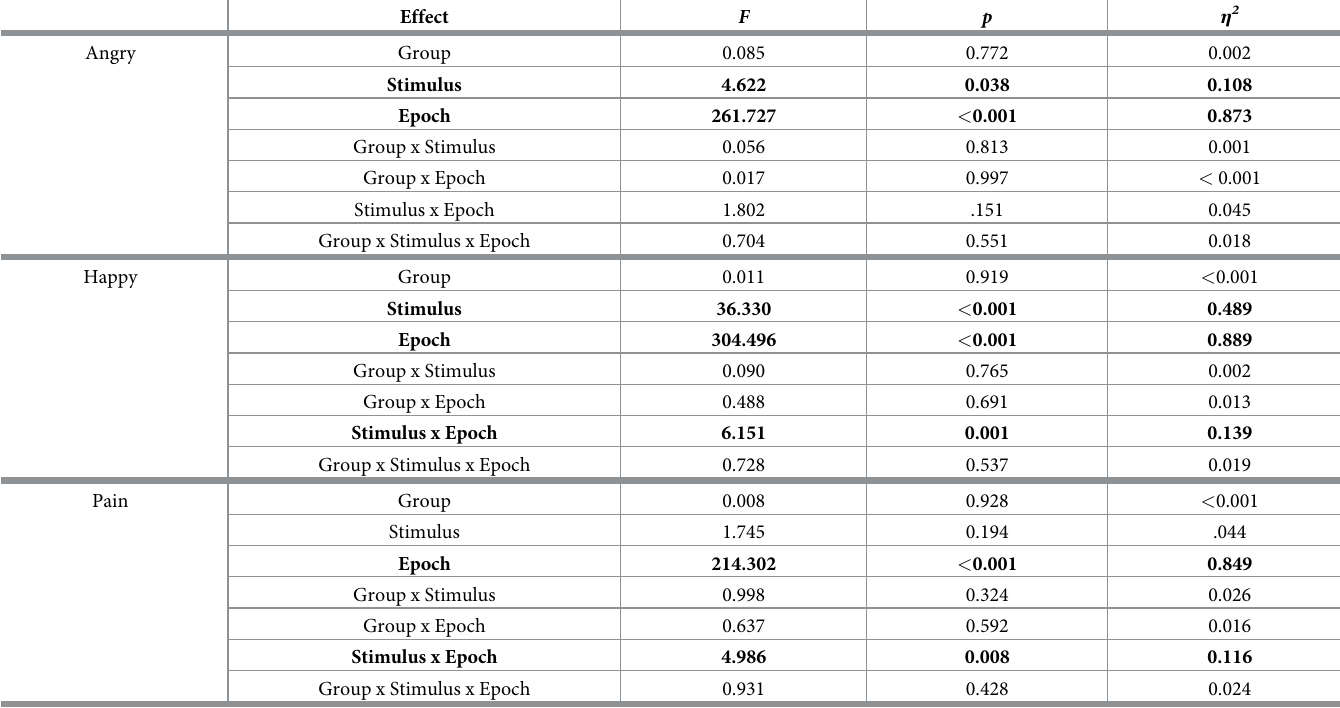
Bold script indicates significant effects ( p <